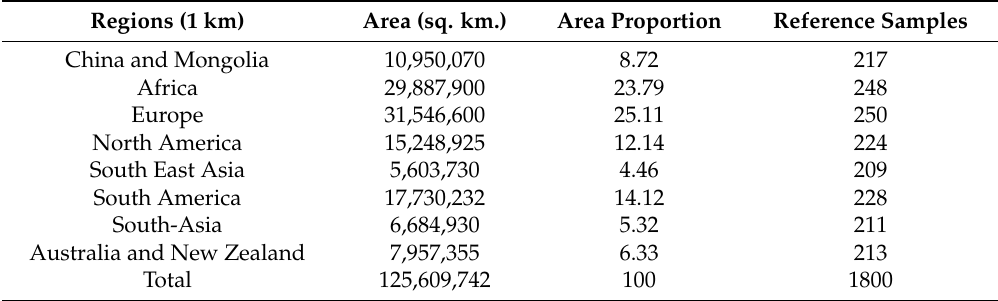
Table 7. The accuracy measures of GFSAD1km map in eight